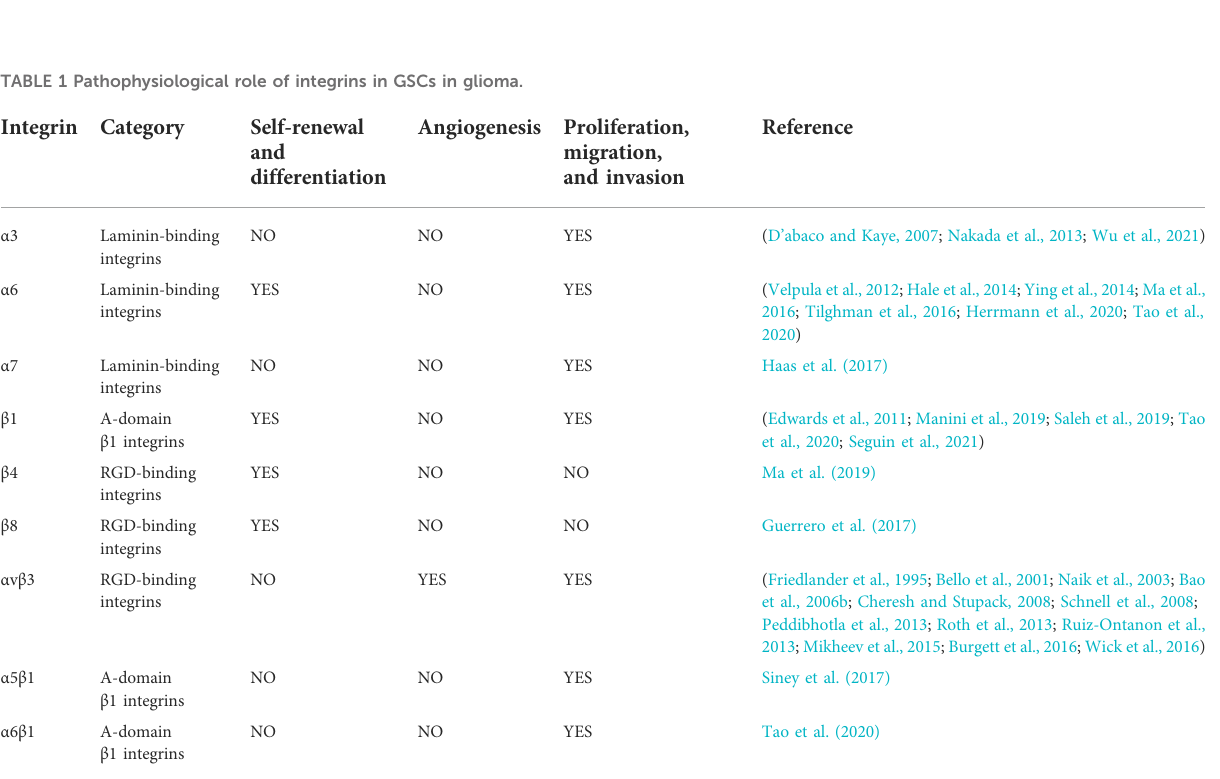
TABLE 1 Pathophysiological role of integrins in GSCs in glioma. Integrin Category Self-renewal